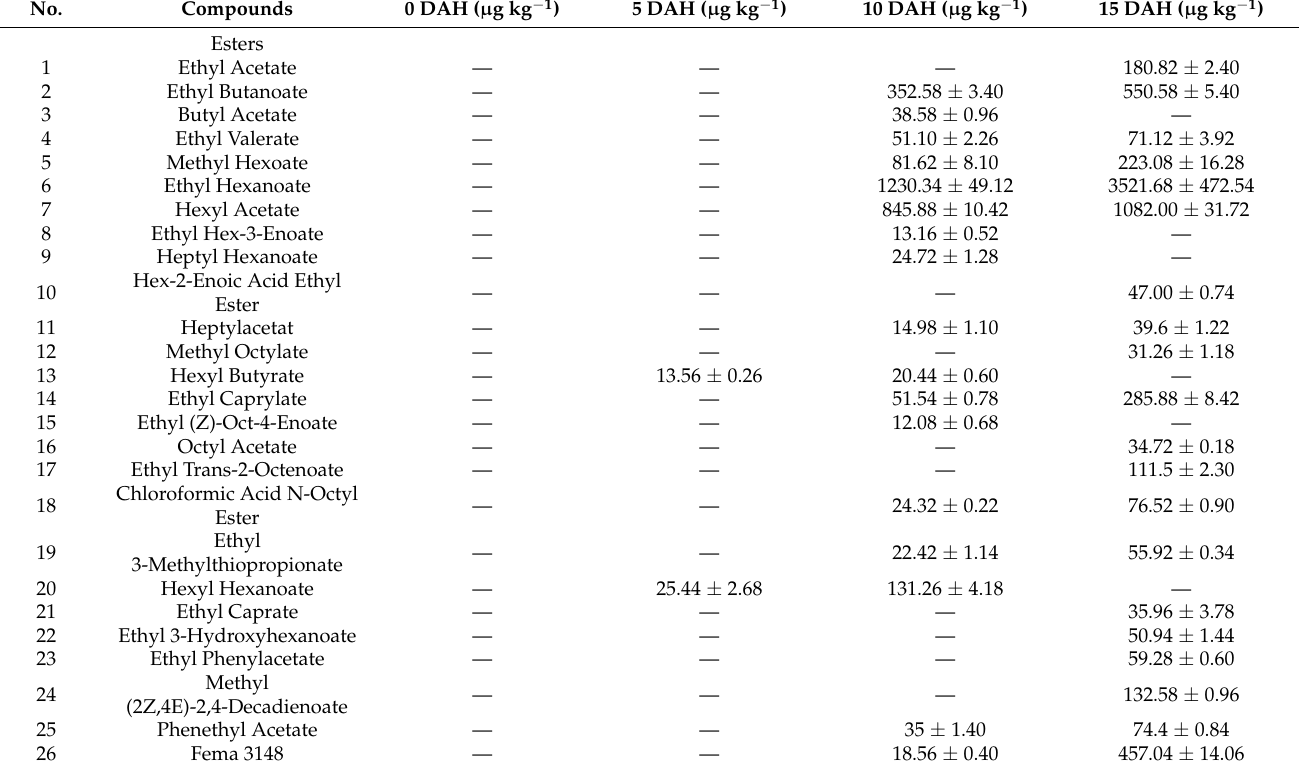
Table 1. Volatile compounds detected in ‘Nanguo’ Pears fruit during fruit